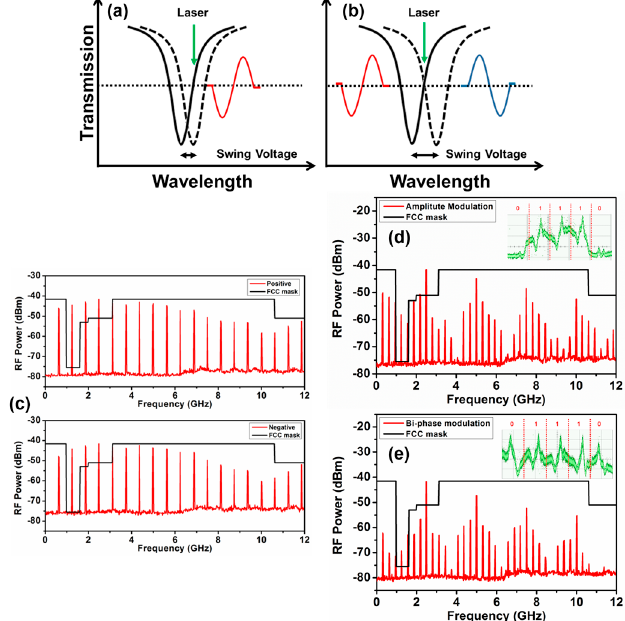
Figure 4. ( a ) Illustration of the principle for amplitude modulation of a monocycle pulse. ( b ) Principle for bi-phase modulation reported in [85]. ( c ) Electrical spectrum of the monocycle pulses with repetition rate of 625 MHz for both positive and negative polarity. ( d ) RF spectrum of the amplitude modulated monocycle pulses. Inset: waveform of the amplitude modulated pulses with a pattern of “01110” without zero padding. ( e ) RF spectrum of the bi-phase modulated monocycle pulses. Inset: waveform of the phase modulated pulses with a pattern of “01110” without zero padding. Courtesy of Hon Ki Tsang [85].